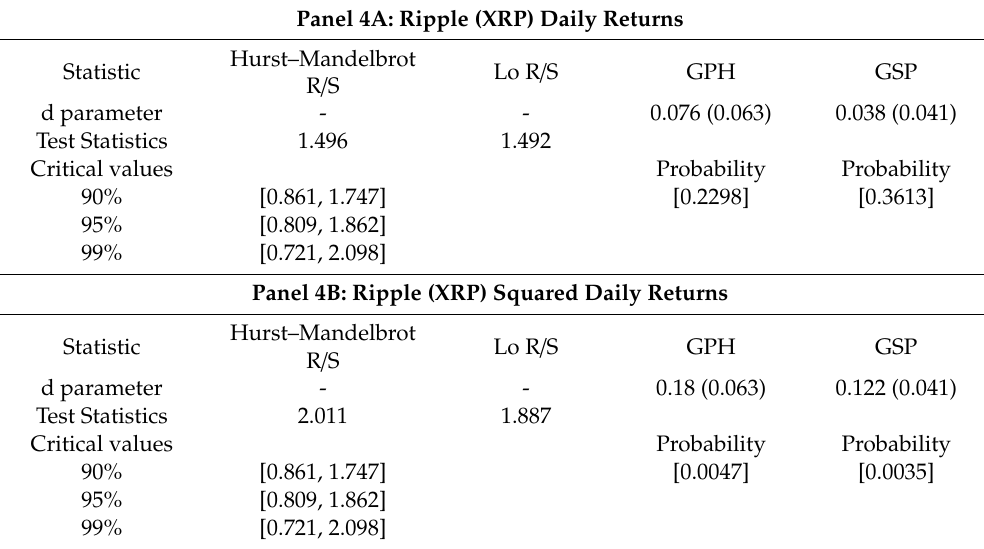
Table 4. Long Memory Tests for Ripple Return and Squared